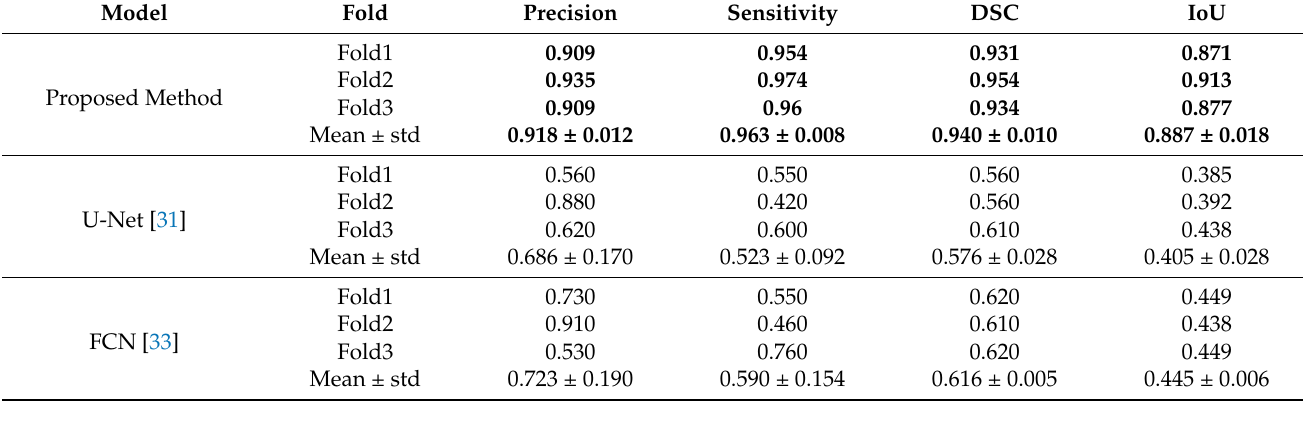
Table 3. The second experiment: quantitative evaluation of the proposed method and the two best-performing baseline models using three-fold cross-validation.